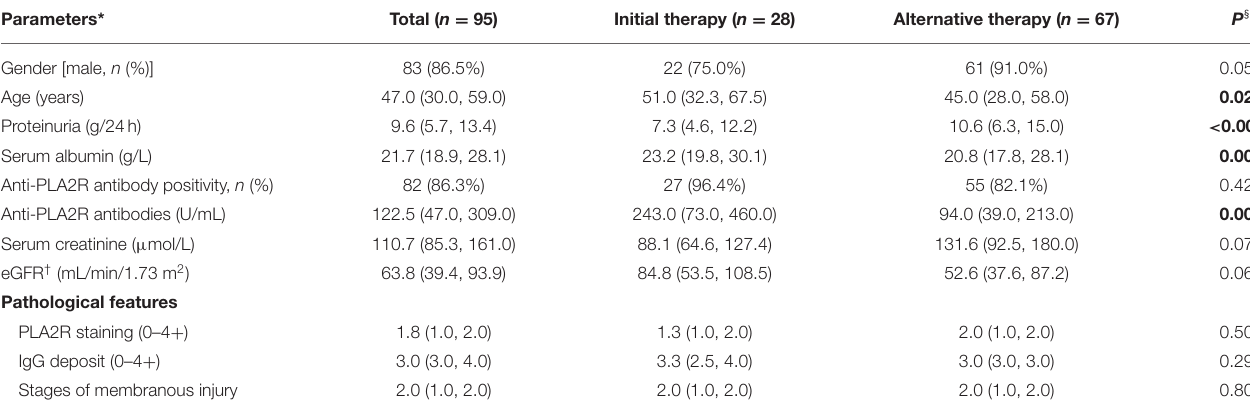
TABLE 1 | Baseline characteristics of patients with pMN included in this study. Parameters*